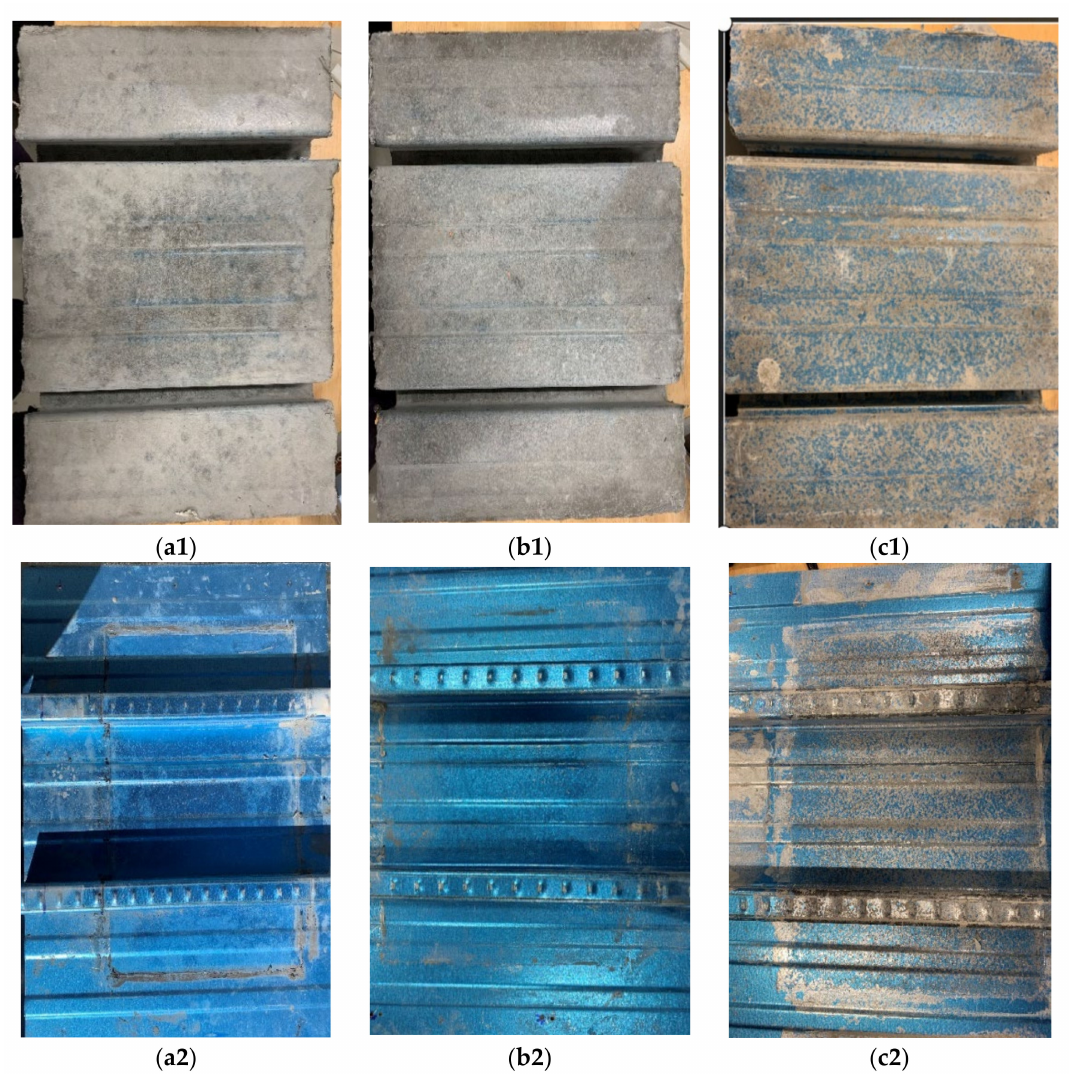
Figure 16. Interface of concrete and steel deck of push-off test specimens. ( a1 ) NC40